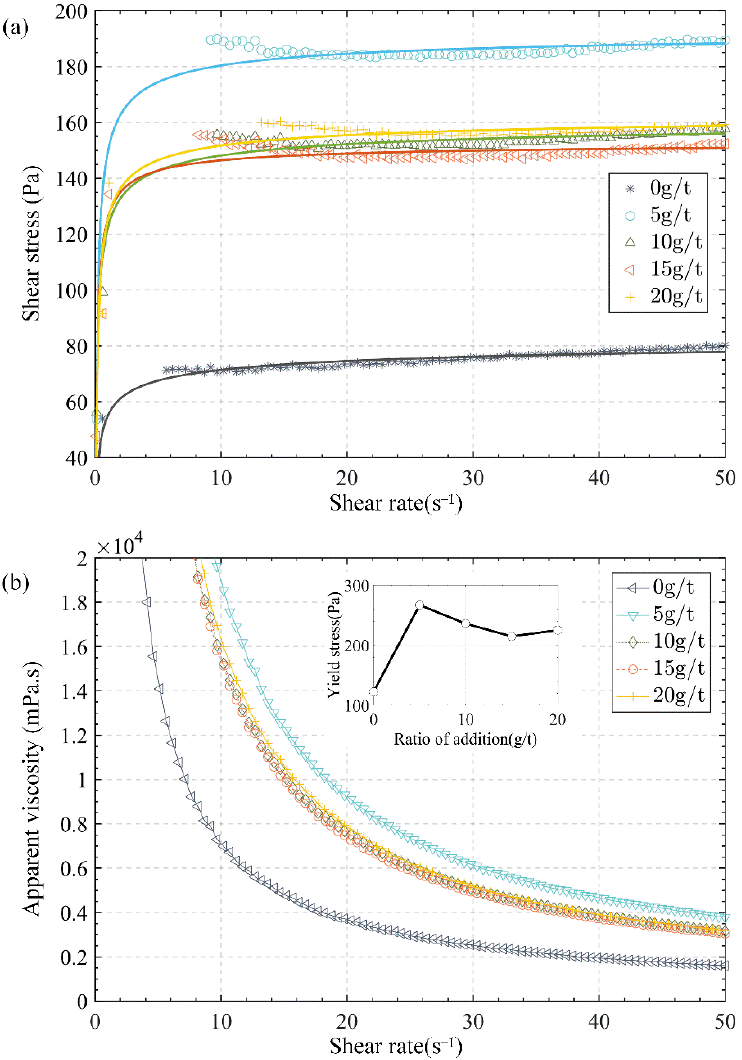
Figure 7. Flow curves of samples with various APAM addition: ( a ) shear rate vs. shear stress; ( b ) shear rate vs. apparent viscosity. The yield stress was presented as a function of ratio addition of APAM in the inset.